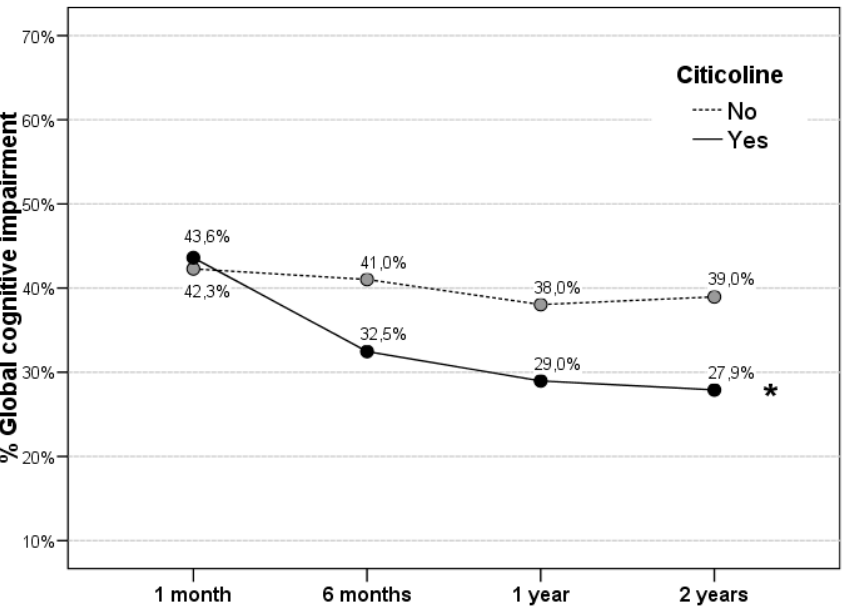
Figure 3. Global cognitive impairment during follow-up. Patients treated with citicoline show a significant improvement in cognitive status during follow-up (* p = 0.005). After the first year, only citicoline-treated patients continue to improve cognitive status.